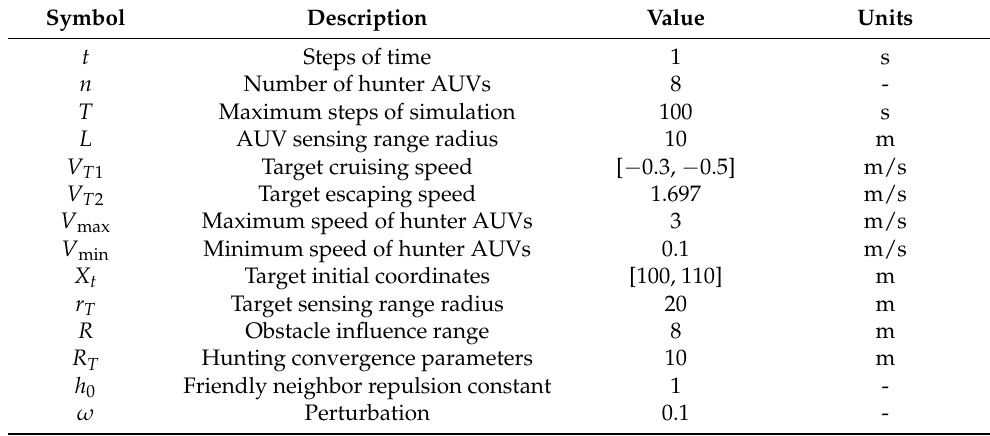
Table 1. Parameters for